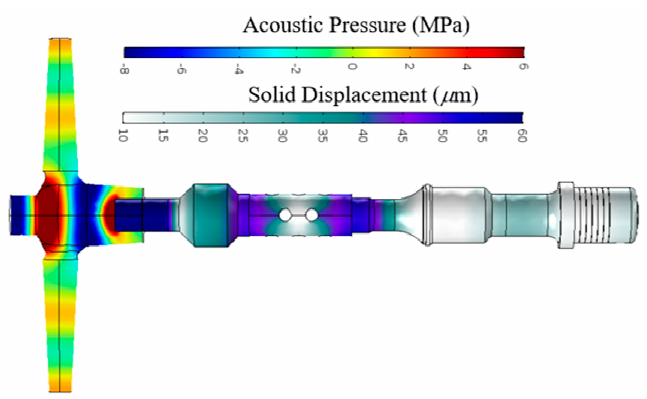
Figure 7. Numerical results of the solid displacement and acoustic pressure obtained for the ultrasonic system apparatus.